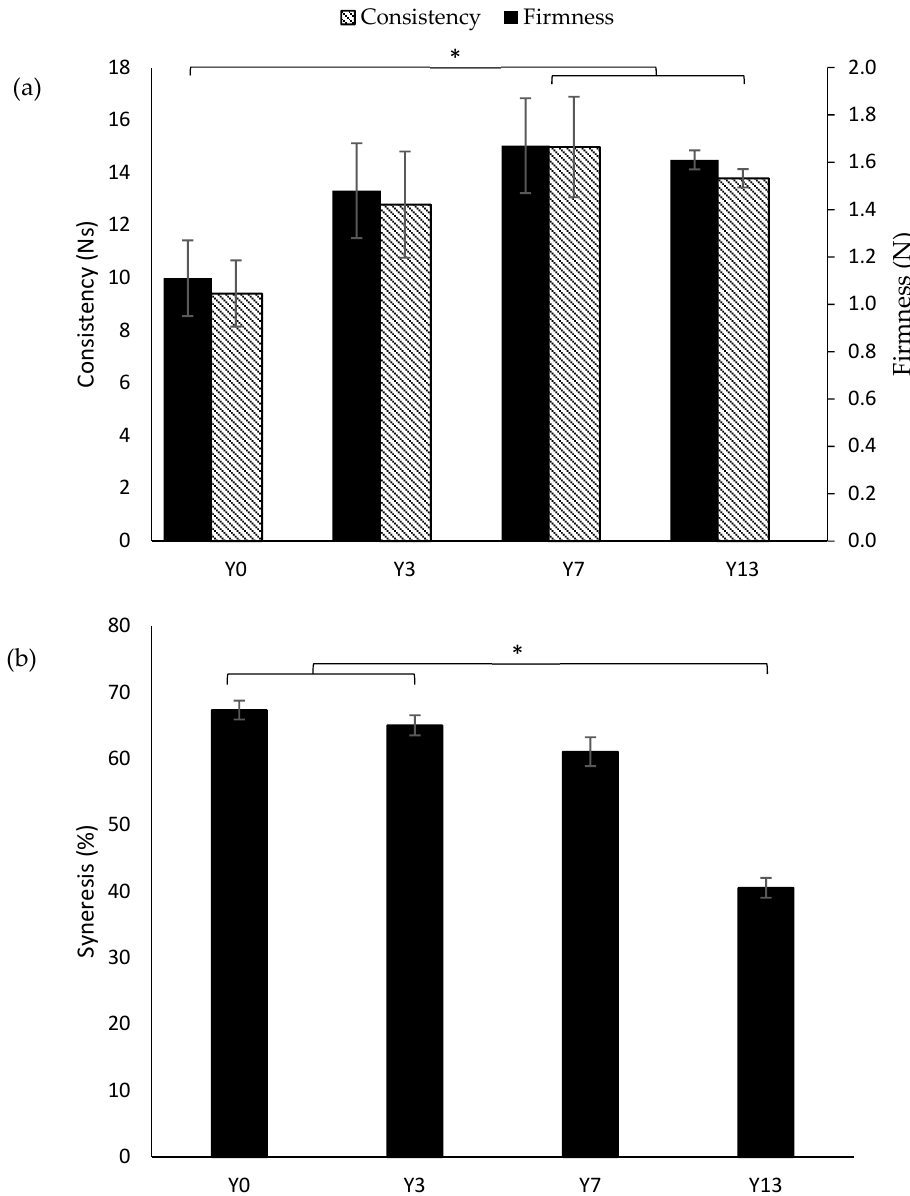
Figure 1. ( a ) Instrumental firmness (N) and consistency (Ns) and ( b ) syneresis (%) of yogurt with cascara extract (Y0), yogurt with cascara extract and 3% inulin (Y3), yogurt with cascara extract and 7% inulin (Y7), and yogurt with cascara extract and 13% inulin (Y13). The asterisk indicates significant differences (Tukey test, * p< 0.05 ).